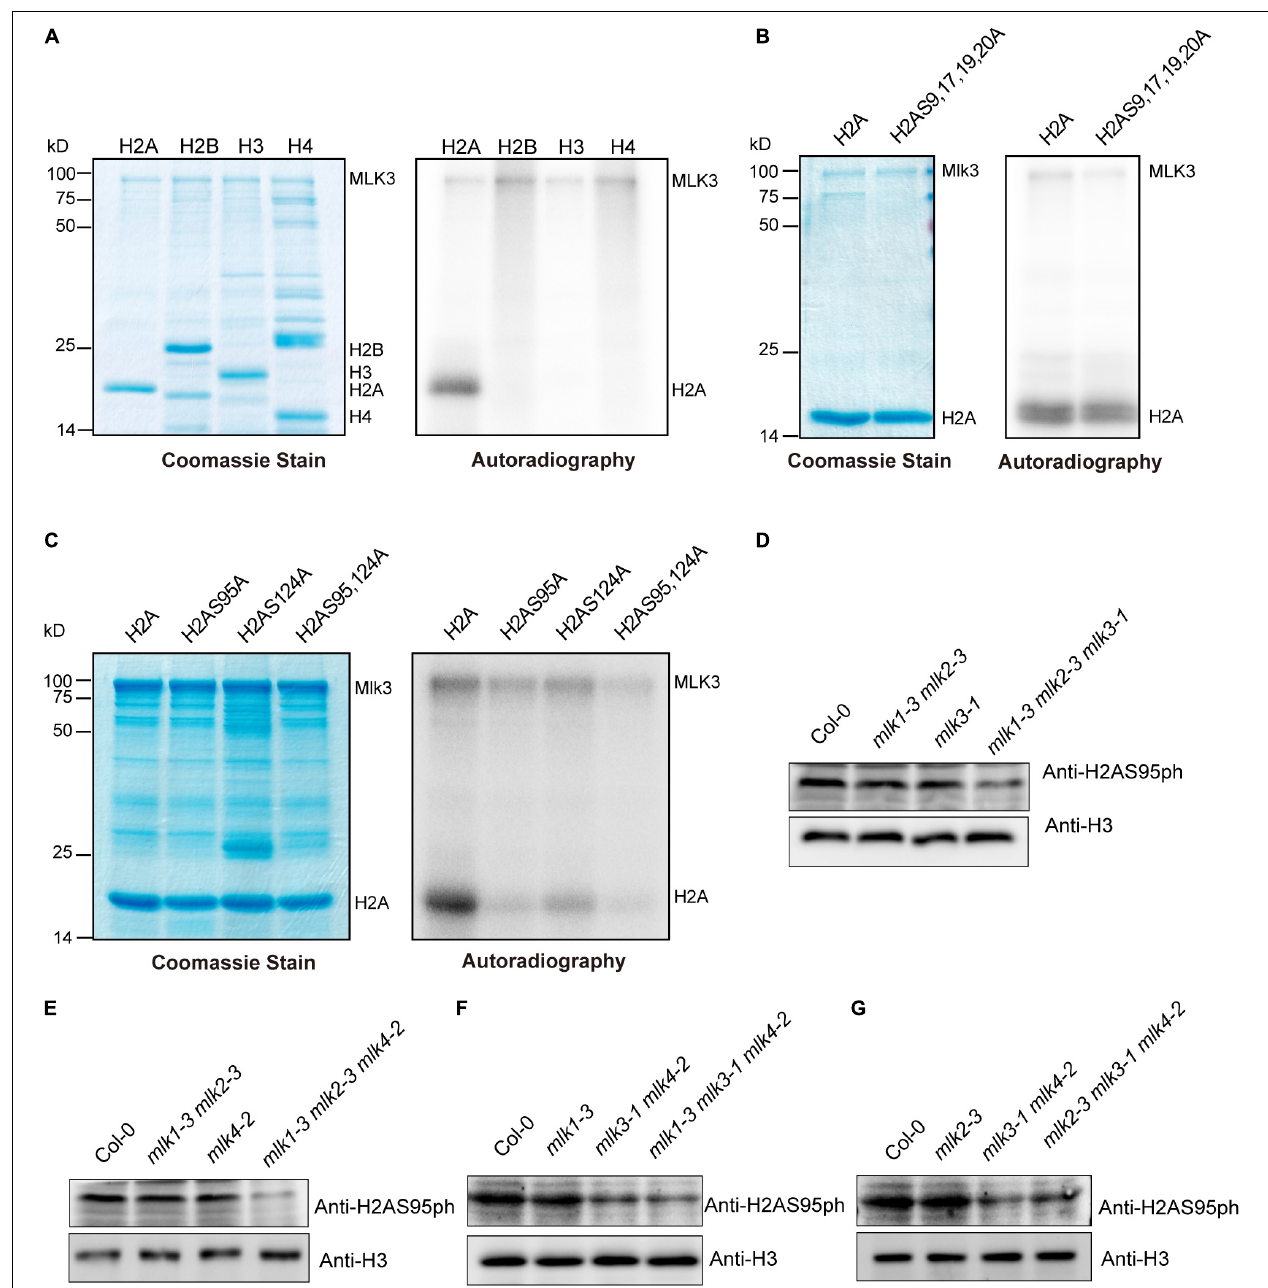
FIGURE 4 | The global changes of H2AS95ph in mlk s plants. (A) MLK3 phosphorylated H2A. The ability of MLK3 to phosphorylate H2A, H2B, H3, and H4 was assessed. The MLK3, H2A, H2B, H3, and H4 were marked. (B,C) The activity and specificity of the MLK3 kinase were assessed using different substrates. Wild-type H2A and H2A containing serine-to-alanine substitutions were used as various residues. (D–G) The global levels of H2AS95 phosphorylation were examined in mlk1 , mlk2 , mlk3 , and mlk4 single mutants, mlk1 mlk2 and mlk3 mlk4 double mutants, and mlk1 mlk2 mlk3, mlk1 mlk2 mlk4, mlk1 mlk3 mlk4, and mlk2 mlk3 mlk4 triple mutants. H3 was used as internal